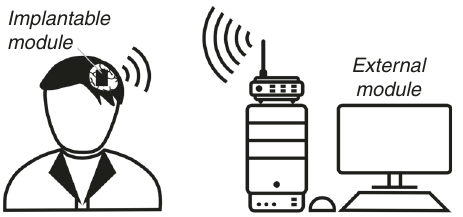
Fig. 1 Illustration of a brain-implantable system, including an implantable module and an external module communicating with each other through wireless connection. In general, the implantable module is con fi gured by the external module through wireless connection. It may also wirelessly receive electric power from the outside. The implantable module comprises a microelectrode array for extracellular recording of neuronal activities, and the electronic circuitry supporting its function. The electronic part usually includes a neural signal preconditioning block, which pre-ampli fi es the signals sensed by the electrode array, fi lters out the out-of-band frequency components, and fi nally digitizes the signals using per-channel or time- shared analog-to-digital converters. After digitization and some signal processing tasks, the recorded signals are telemetered through a wireless link to the external